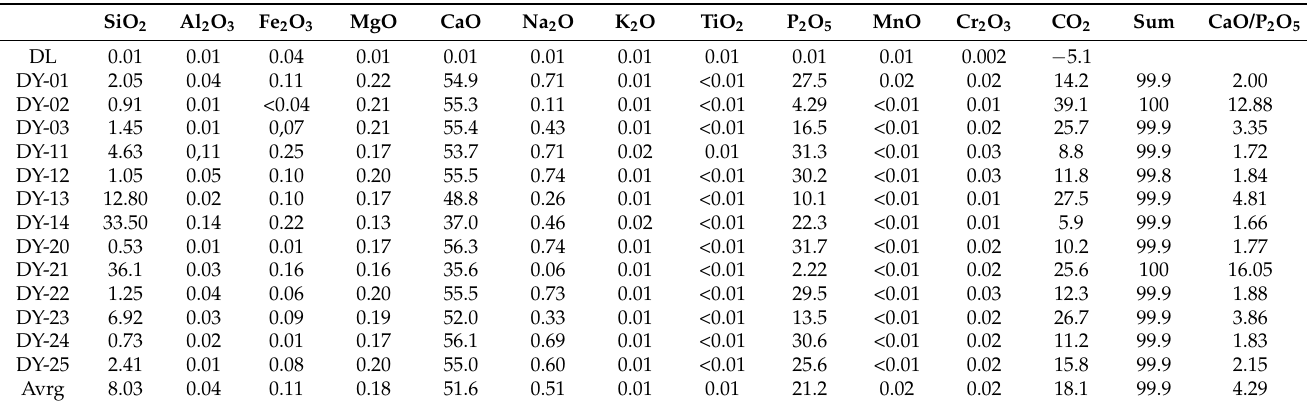
Table 1. Major oxide contents (%) of the phosphate samples.